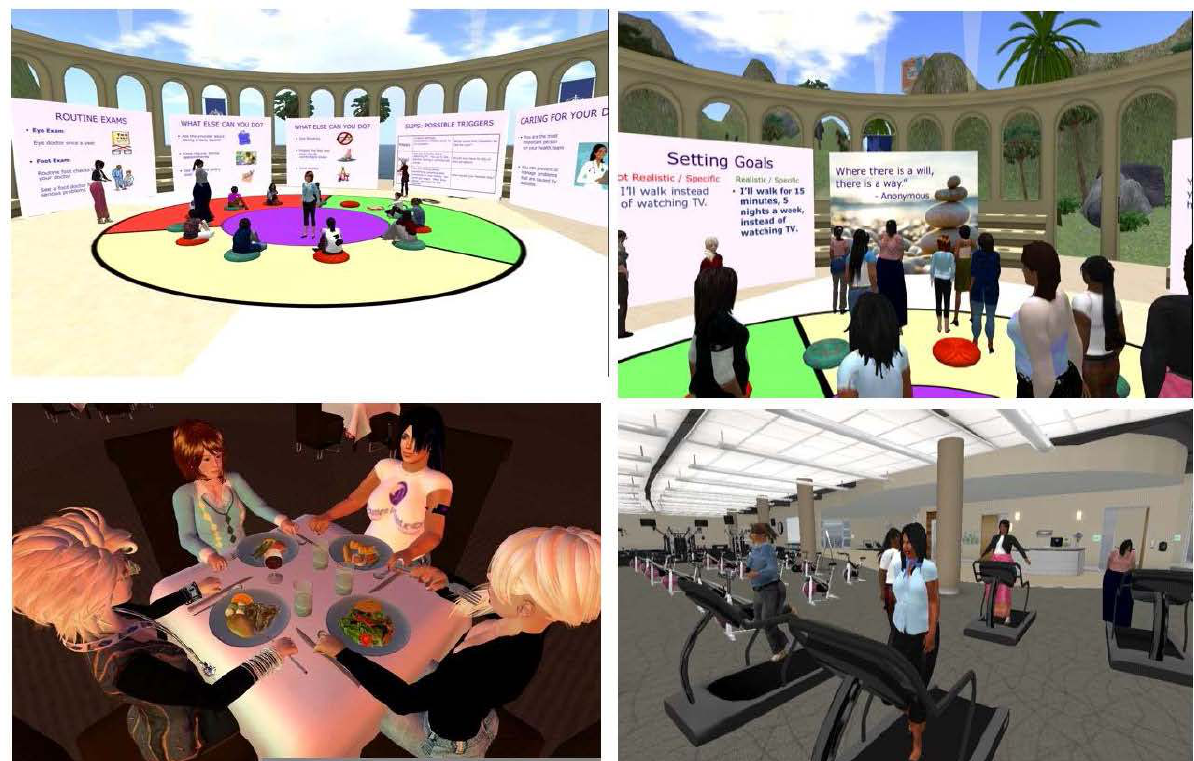
Figure 2. Pictures of the Virtual World participants engaged in various intervention